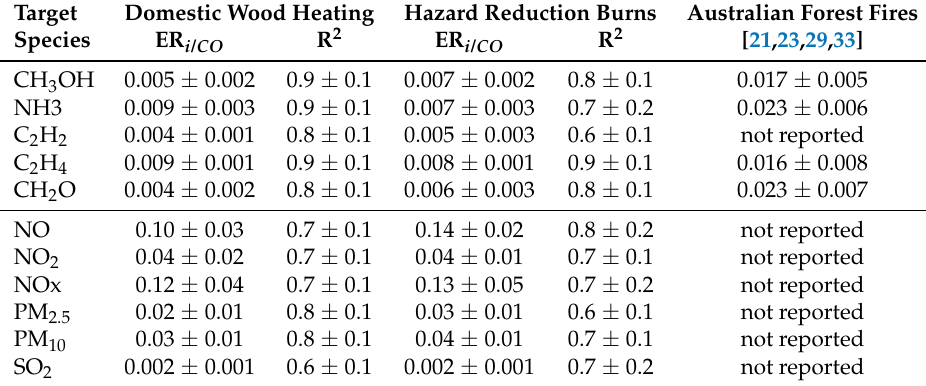
Table 5. Linear Regression enhancement ratios of trace gases and particulate matter against CO retrieved from domestic wood heating and hazard reduction burn smoke periods. Those enhancement ratios were retrieved from a selected 16 domestic wood heating and 5 hazard reduction burns events. The uncertainties quoted are the standard deviations of the average of all events. Whilst there will be other systematic uncertainties, these will be the same for both sources of smoke and therefore will